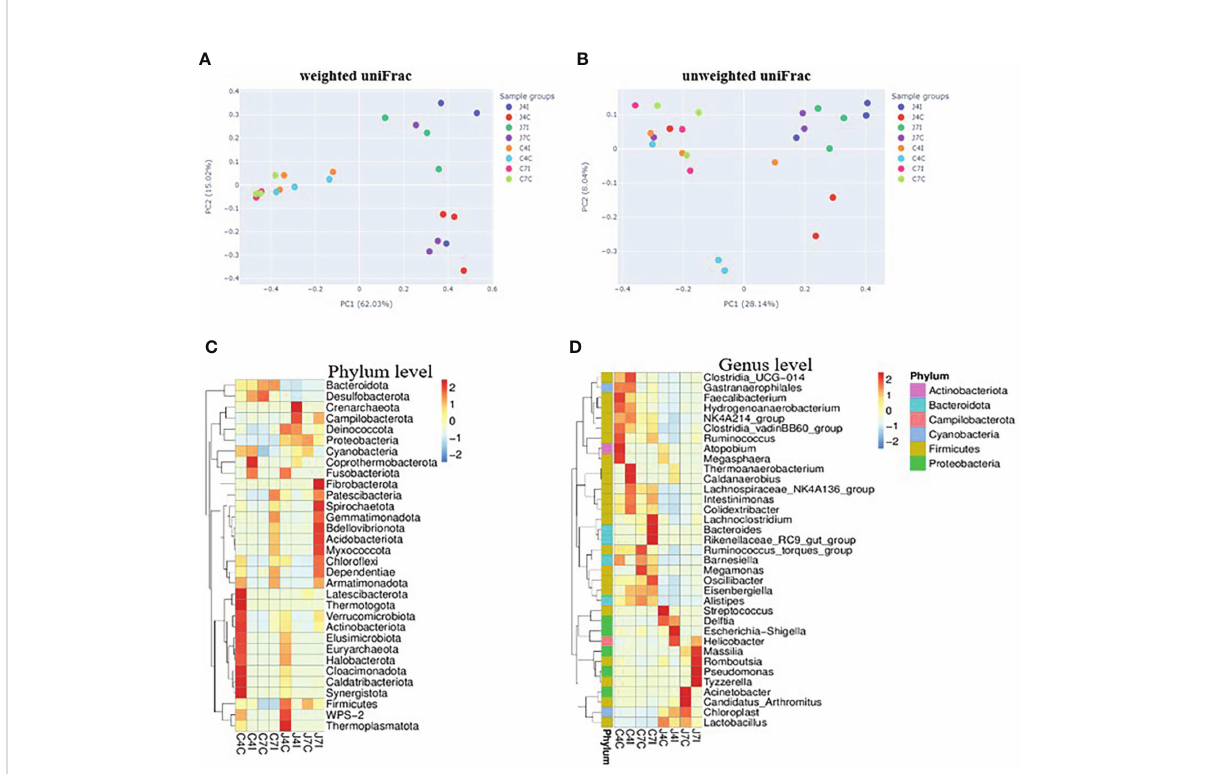
FIGURE 5 PCA analysis of operational taxonomic units from sample groups. (A) weighted uniFrac of jejunum and cecum groups (B) unweighted uniFrac jejunum and cecum groups. The different colours in the PCA plot are represents different sample groups, and the closer sample distance point has more like the microbial composition. The microbial abundance heat map shows the hierarchical distribution of the phylum and genus levels. (C) Microbial cluster distribution of 32 phyla. (D) Microbial cluster distribution of 35 genus. The colour intensity in each panel shows the percentage of microbial composition referring to the colour key